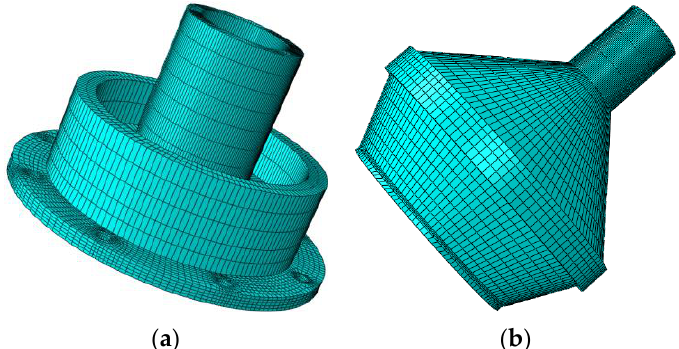
Figure 6. Rotor finite element model. ( a ) First-stage disc finite element model. ( b ) Second-stage disc finite element model.